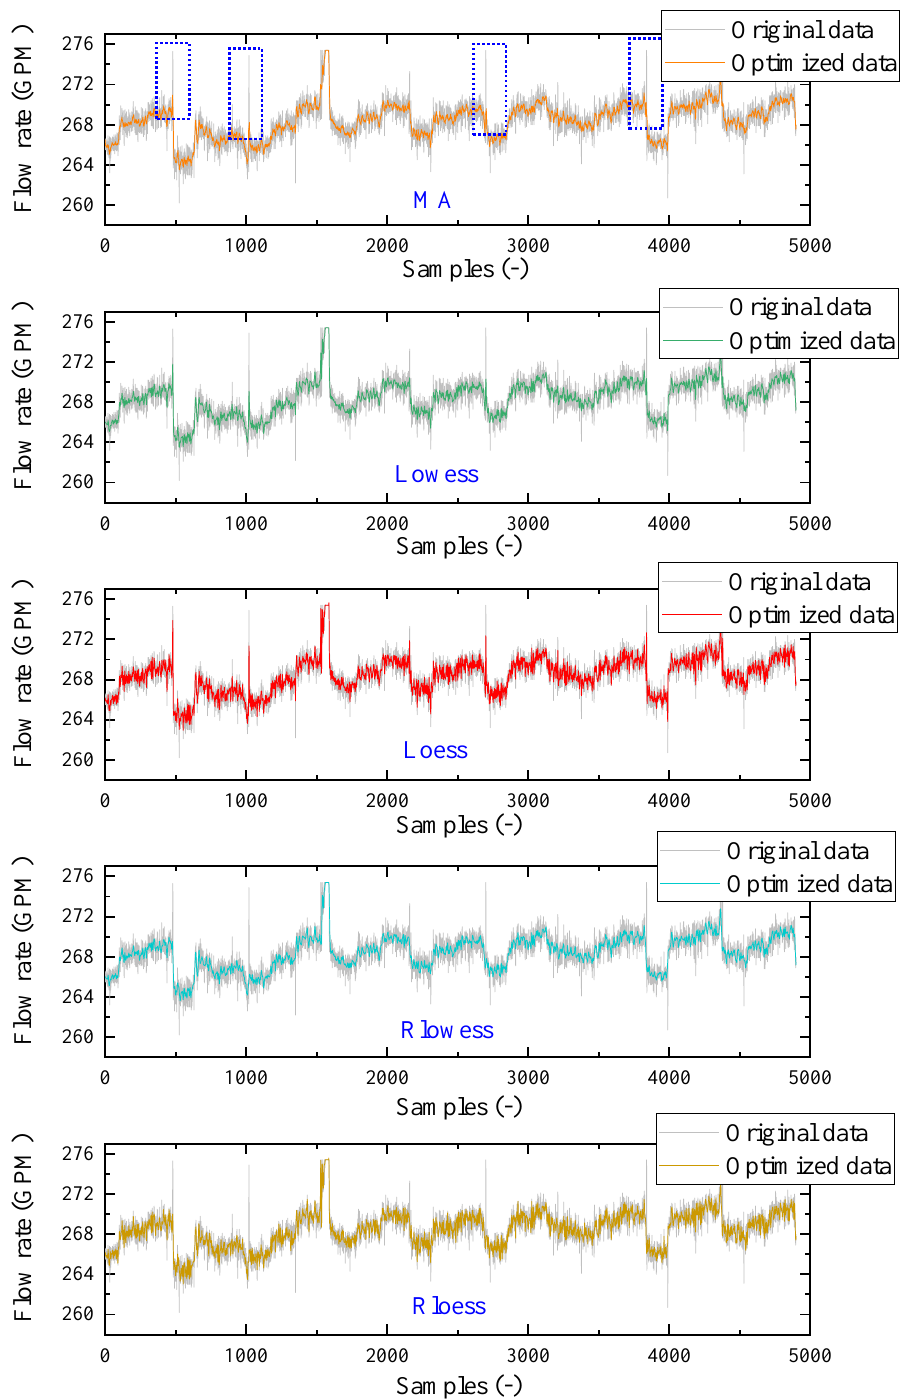
Figure 3. Data optimization results of cooling water flow rate for different data smoothing methods.